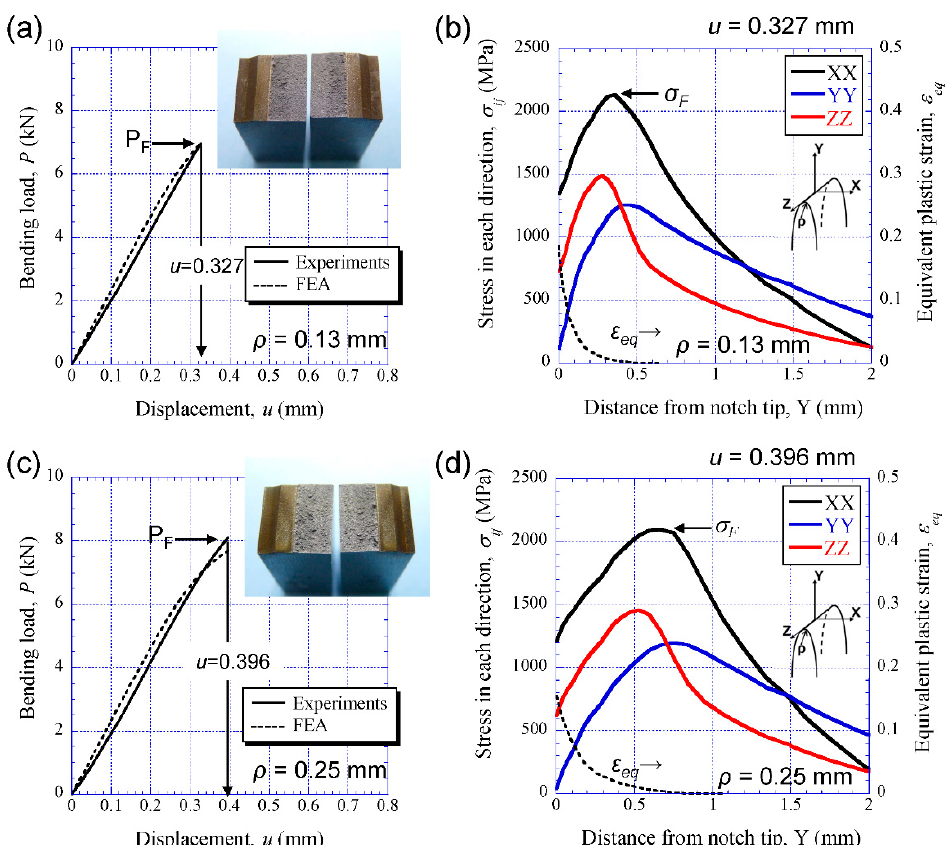
Figure 7. ( a ) Comparison between the P - u relations in the SM10 specimen with ρ = 0.13 mm, and the appearance of the sample. ( b ) Distributions of the stresses and the equivalent strain ε eq near the notch tip at u = 0.327 mm obtained via finite element analysis (FEA). ( c ) The P - u relations in the SM10 specimen with ρ = 0.25 mm. ( d ) Distributions of the stresses and the ε eq near the notch tip at u = 0.396 mm obtained via FEA. Here, ρ denotes the initial notch radius.